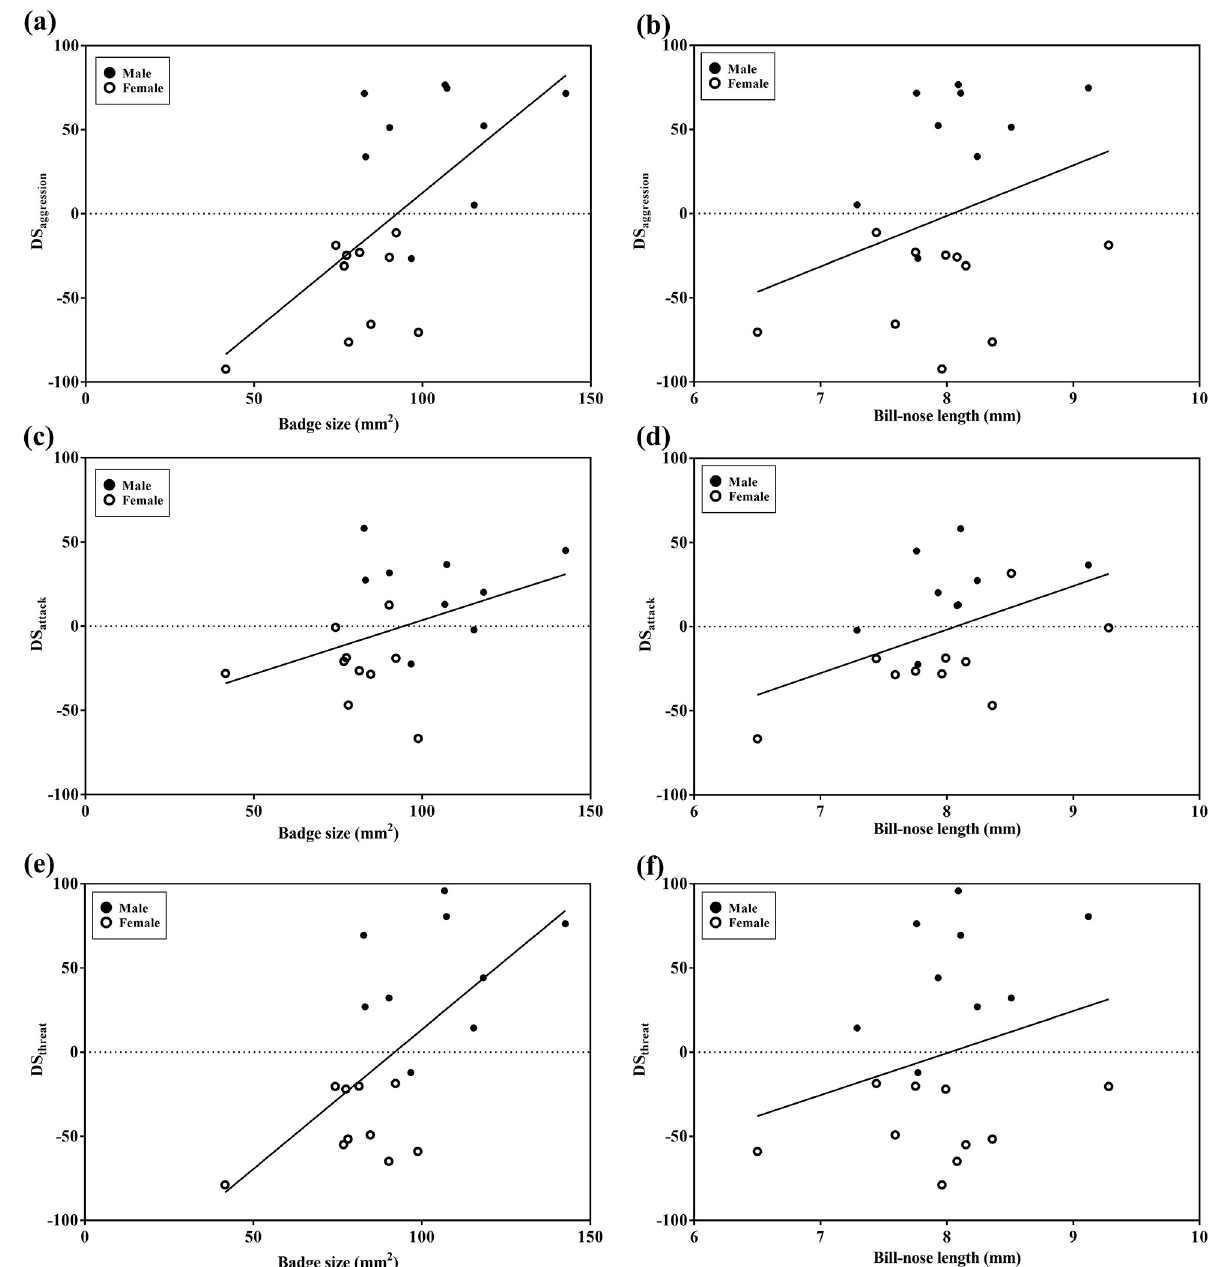
Fig 2. The relationship between either morphological trait or DS scores. The relationship between either morphological trait and badge size (a, c, e) or morphological traits and bill–head length (b, d, f) in relation to DS aggression (a, b), DS attack (c, d), and DS threat (e, f). Higher David’s scores (DS) indicate more dominant individuals. Solid lines indicate the estimated effect of morphological traits on dominance